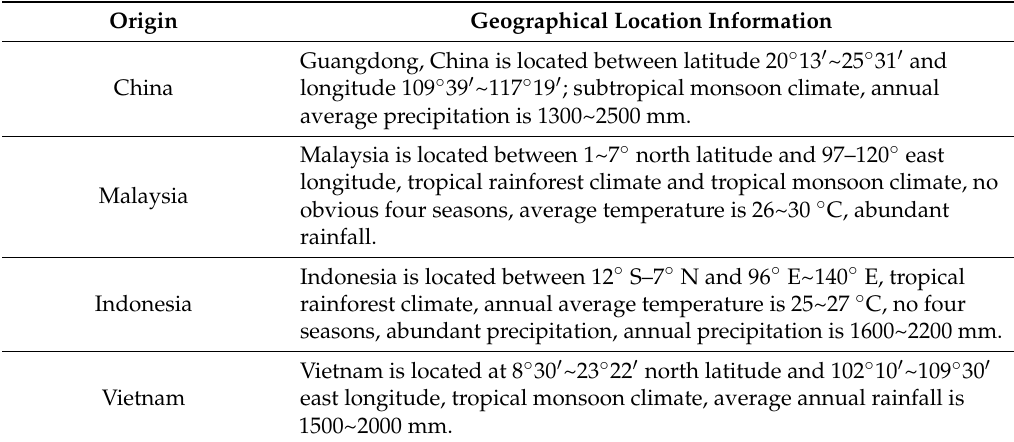
Table 5. Climatic information of agarwood from different